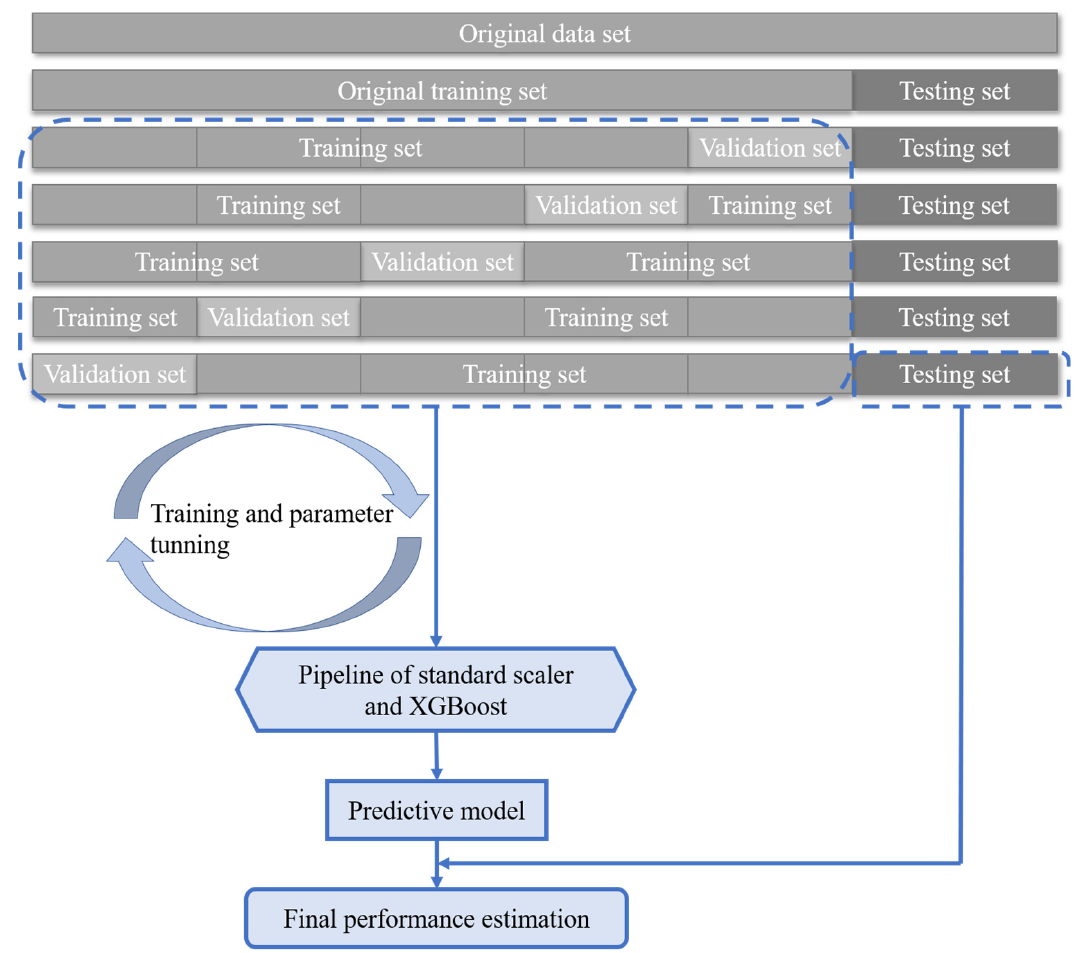
Figure 6. The procedure of the proposed algorithm.